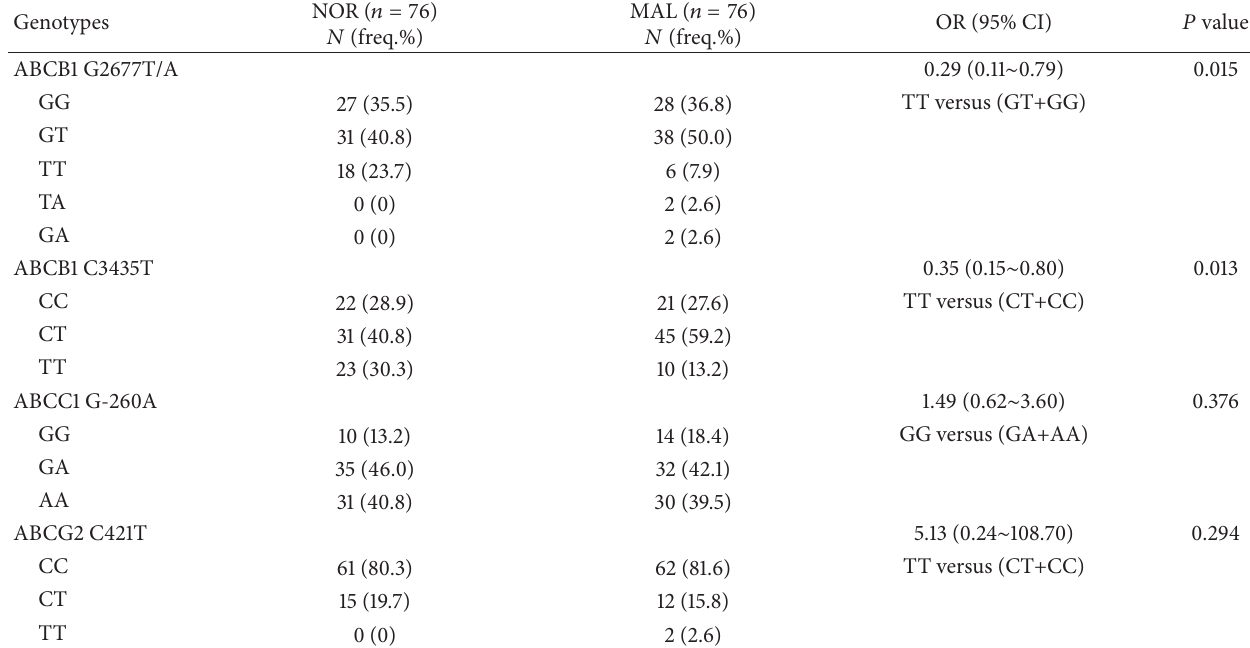
Table 2: Genotypic frequency in the whole study